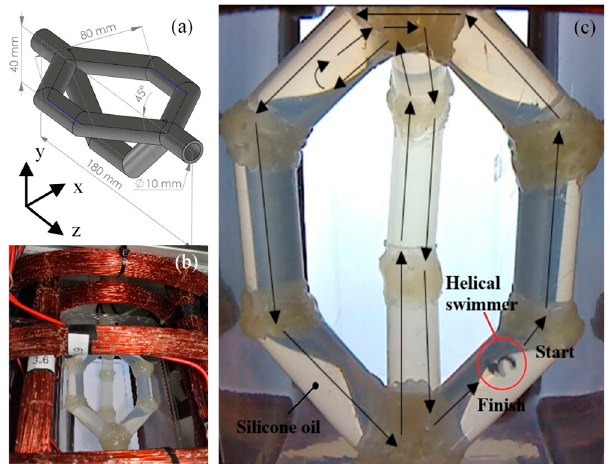
Figure 12. Helical propulsion following the complex network path. ( a ) the model of the path built by using Ø10-mm rubber tubes, and fully filled by 350-cst. silicone oil. ( b ) the path is inserted into the bore of the system. ( c ) under rotating magnetic field, the helical microswimmer swims along the complex network path, black arrows define the swimming path of the swimmer, and red circle indicates the swimmer, the start and finish